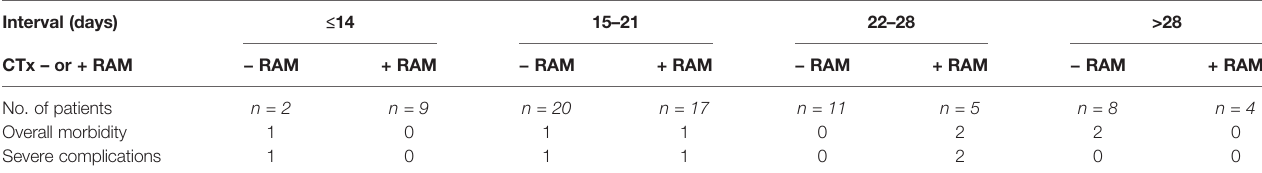
TABLE 6 | Effect of interval between systemic chemotherapy with or without ramucirumab (+ RAM or – RAM, respectively) and PIPAC on postoperative complication rates. Interval (days) ≤